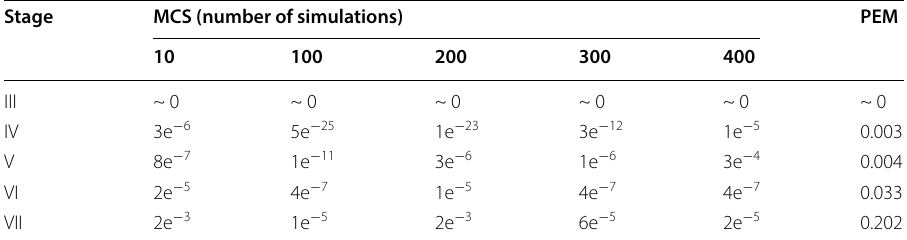
Table 8 Probability of failure at different stages of construction Stage